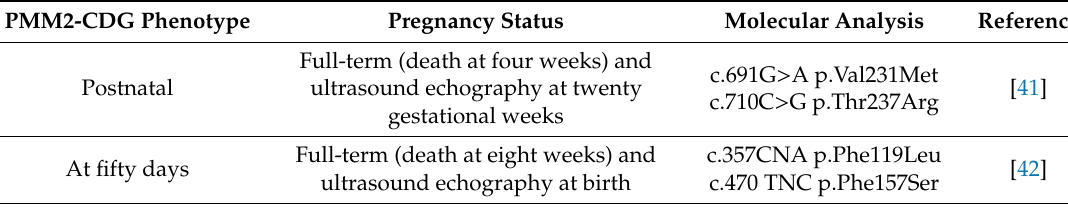
Table 1. The outcomes and consequences related to PMM2 gene